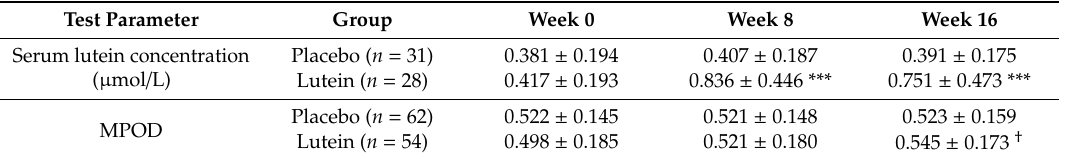
Table 4. Changes in serum lutein levels and macular pigment optical density (MPOD) values after supplementation.